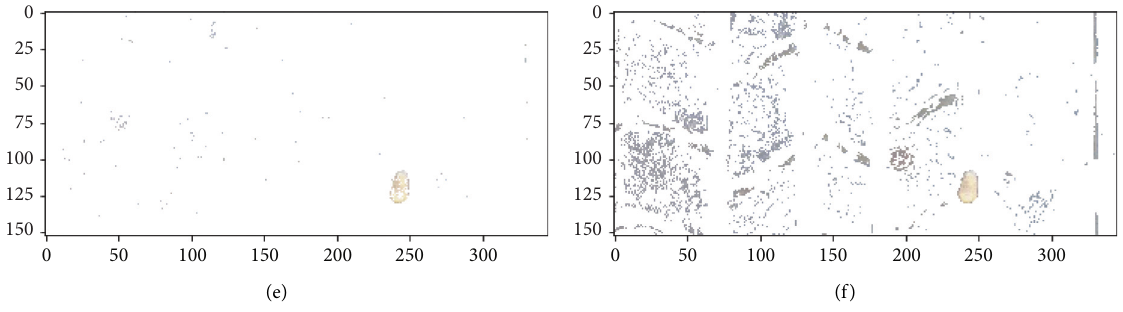
Figure 6: Clustering results on Tyre #2 (345 × 152 pixels, p � 99, N � 52440, and n with k � 2. (c) Our algorithm with k � 3. (d) k -means with k � 3. (e) Our algorithm with k � 4. (f) k -means with k �